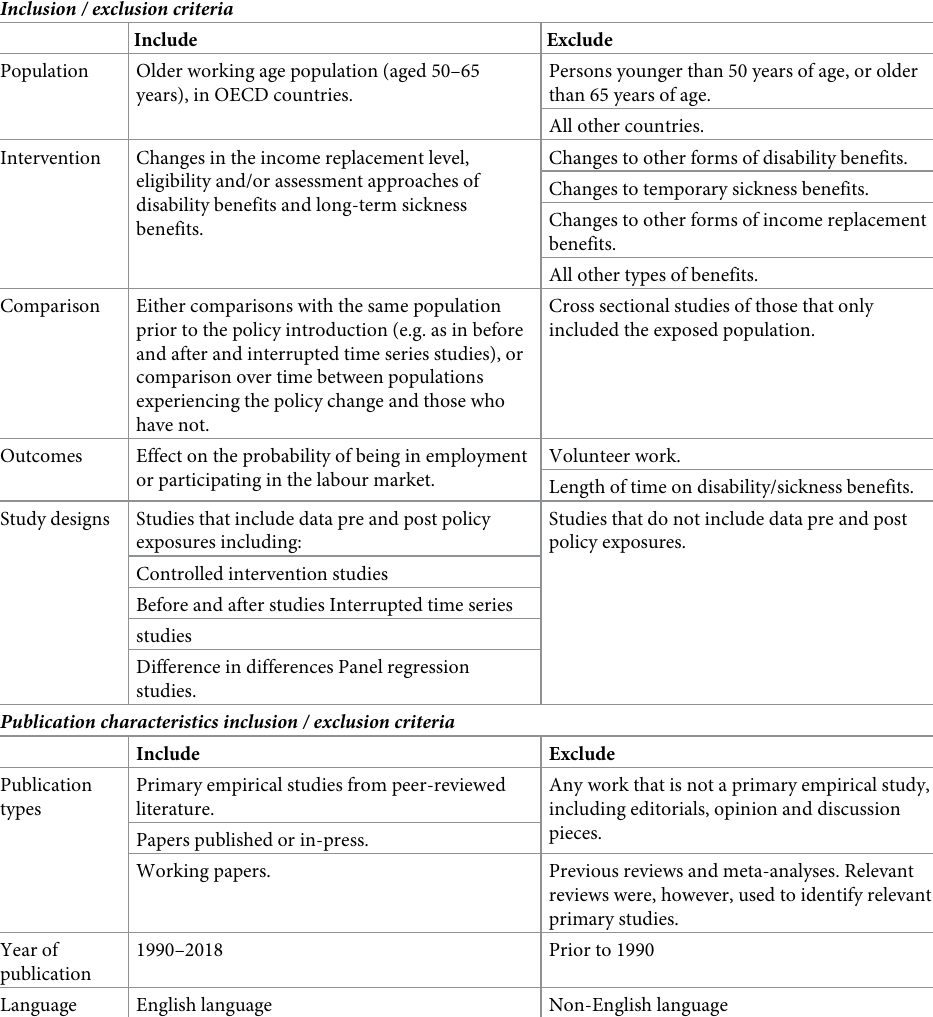
Table 1. Inclusion/Exclusion criteria for systematic